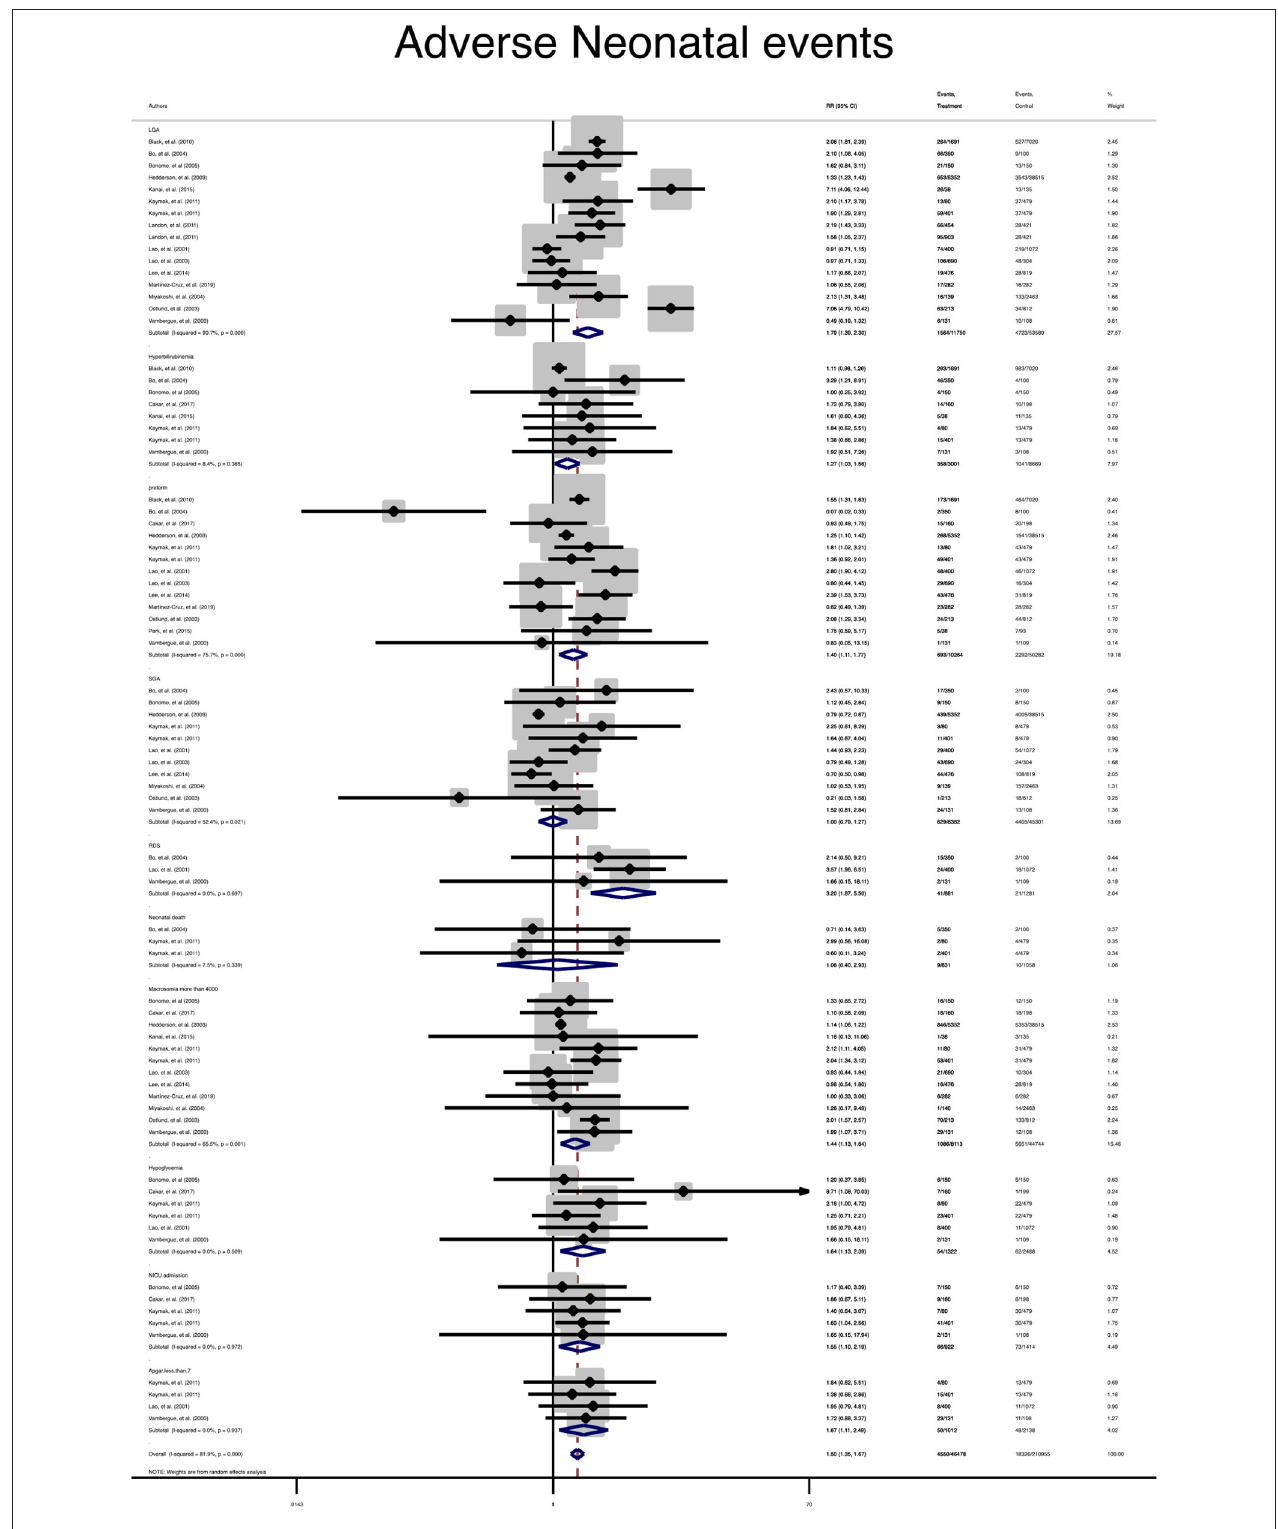
FIGURE 3 | Forest plot of pooled relative risk of adverse neonatal events.